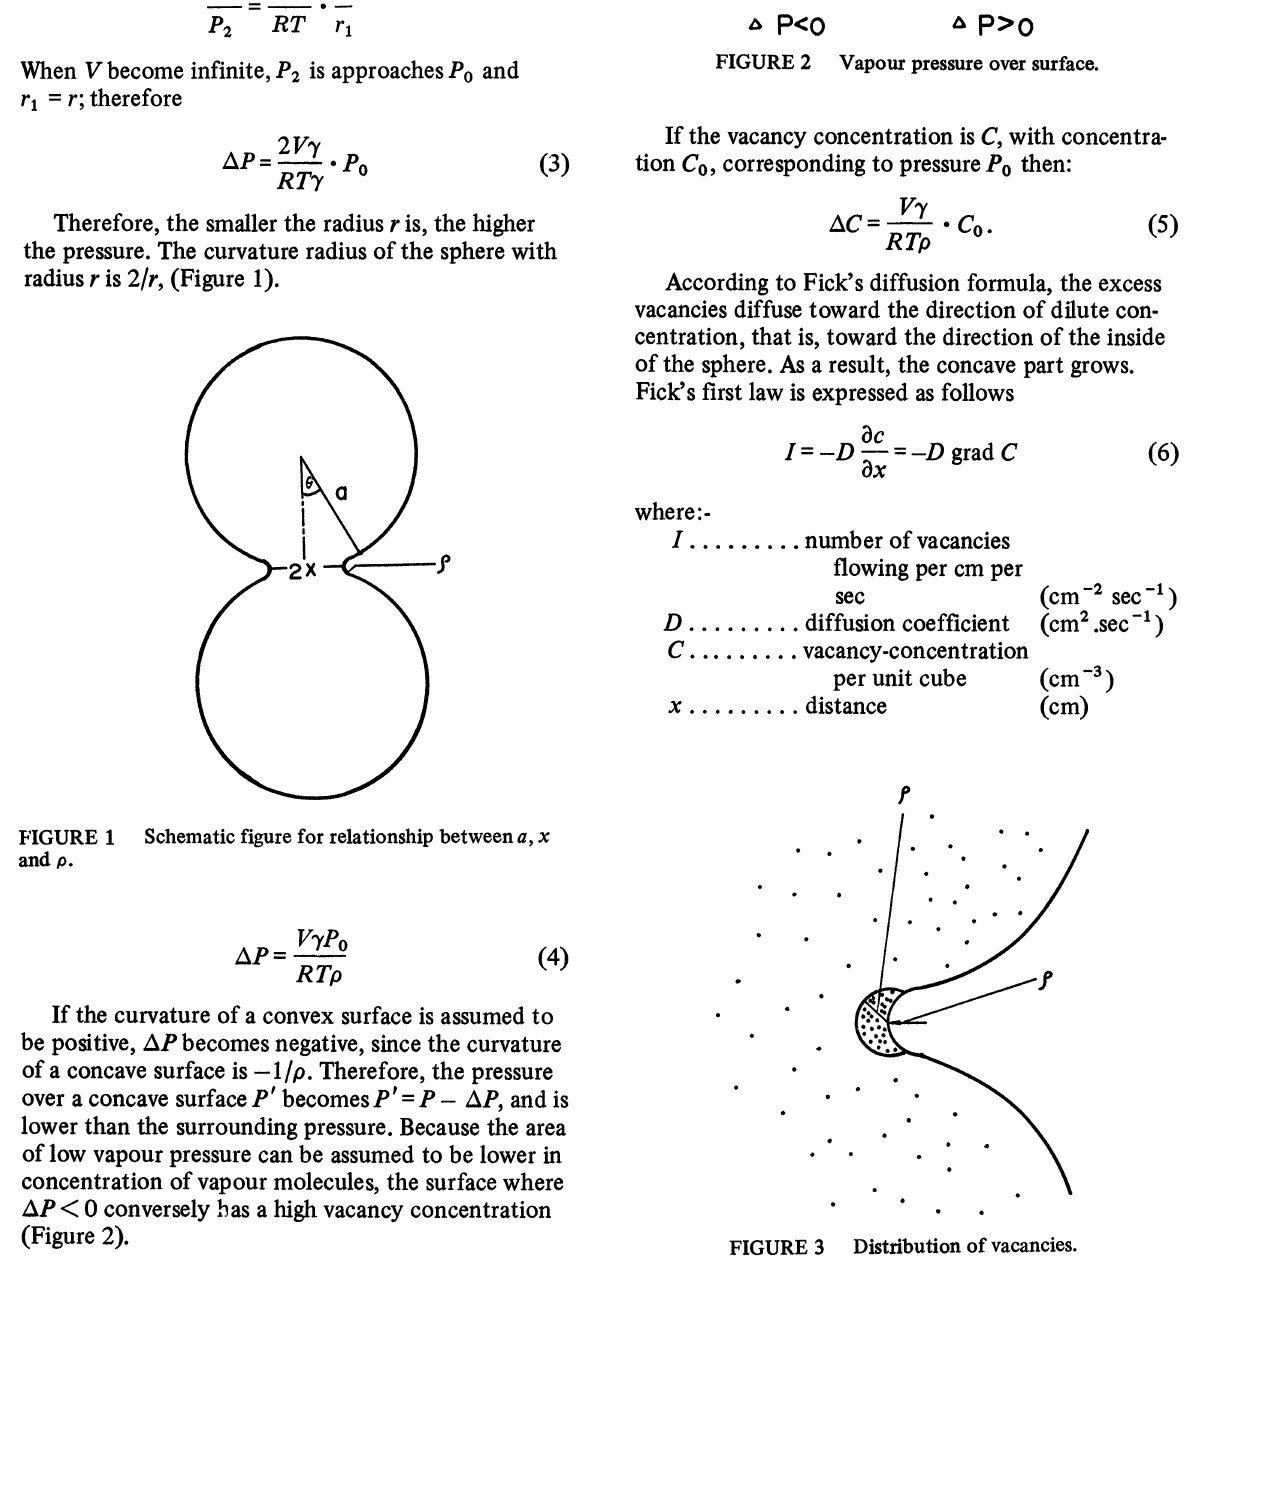
FIGURE 2 Vapour pressure over surface.